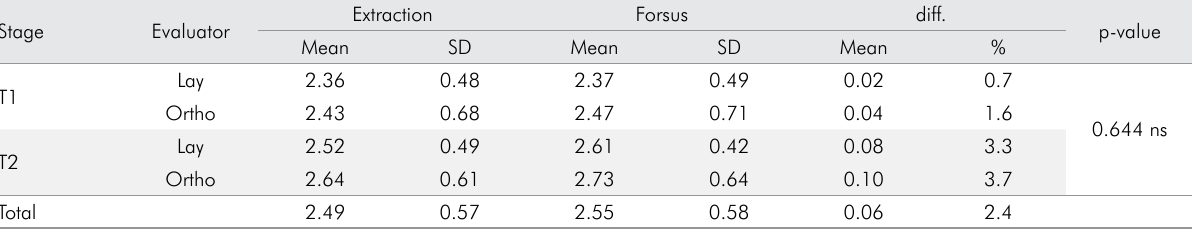
Table 2. Three-way mixed-model analysis of variance for comparison of scores assigned according to the treatment protocols.